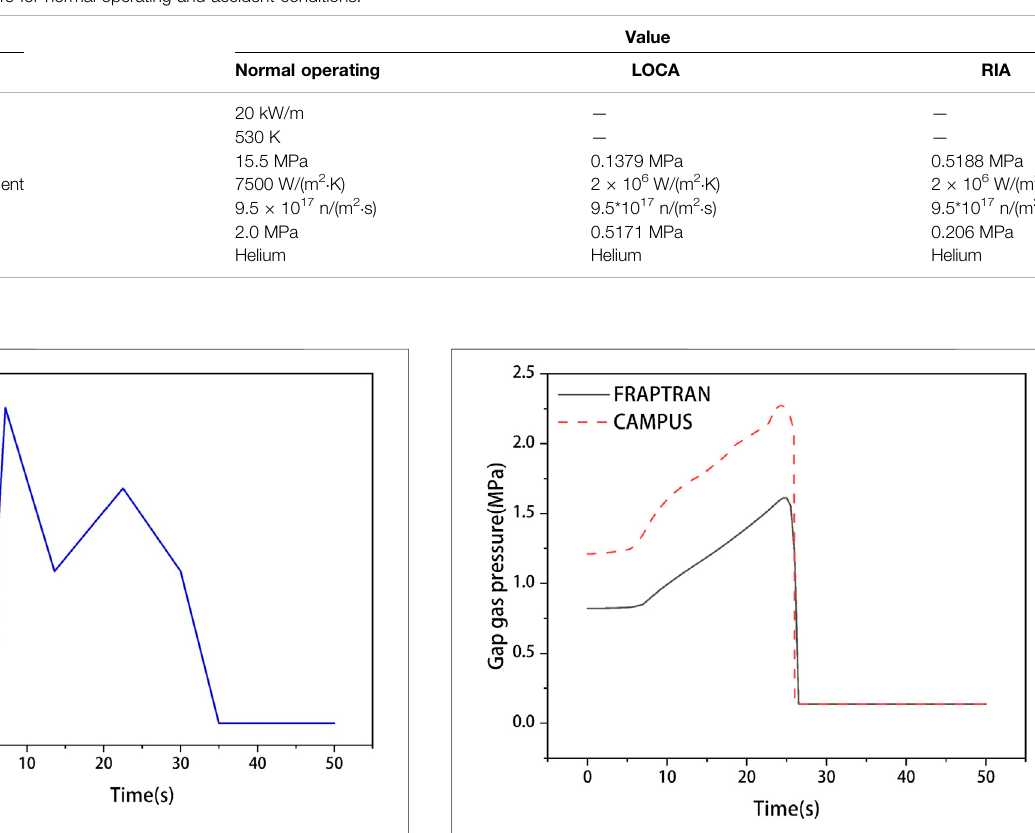
FIGURE 3 | Plenum pressure evolutions of the UO 2 fuel with Zircaloy cladding calculated by the FRAPTRAN and CAMPUS codes under the LOCA condition.